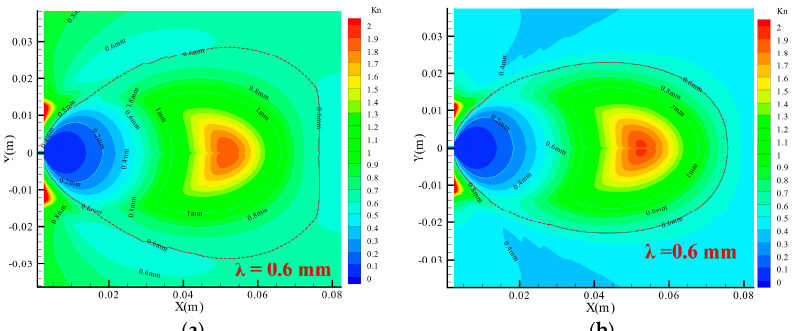
Figure 15. Kn contour with λ contour map of different external temperature (The red line marked in the figure represents =0.6mm λ and the dotted line is an imaginary line to fix the discontinuity. ). ( a ) 393 K; ( b ) 173 K.